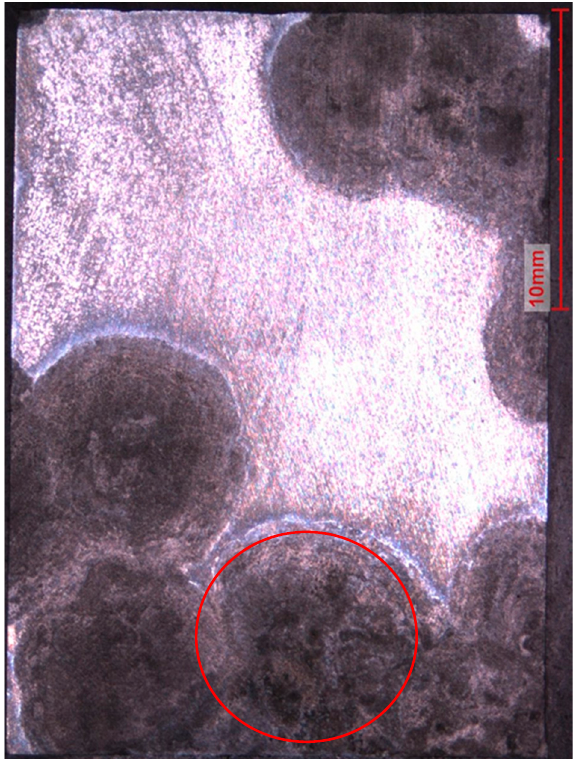
Figure 15. An image of sample S13 exposed to seawater with bacteria for 28 days (after cleaning). Half of the surface area was attacked by local corrosion.